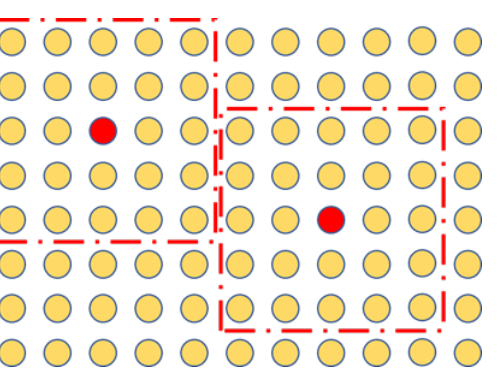
Figure 3. Spatial neighborhood of data pre-processing. The red dashed line indicates the width of the selected pixels’ spatial